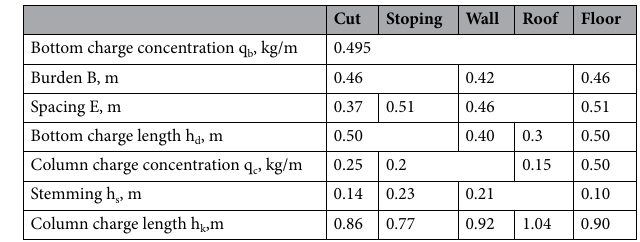
Table 5. Drilling and charging geometry for single V cut.